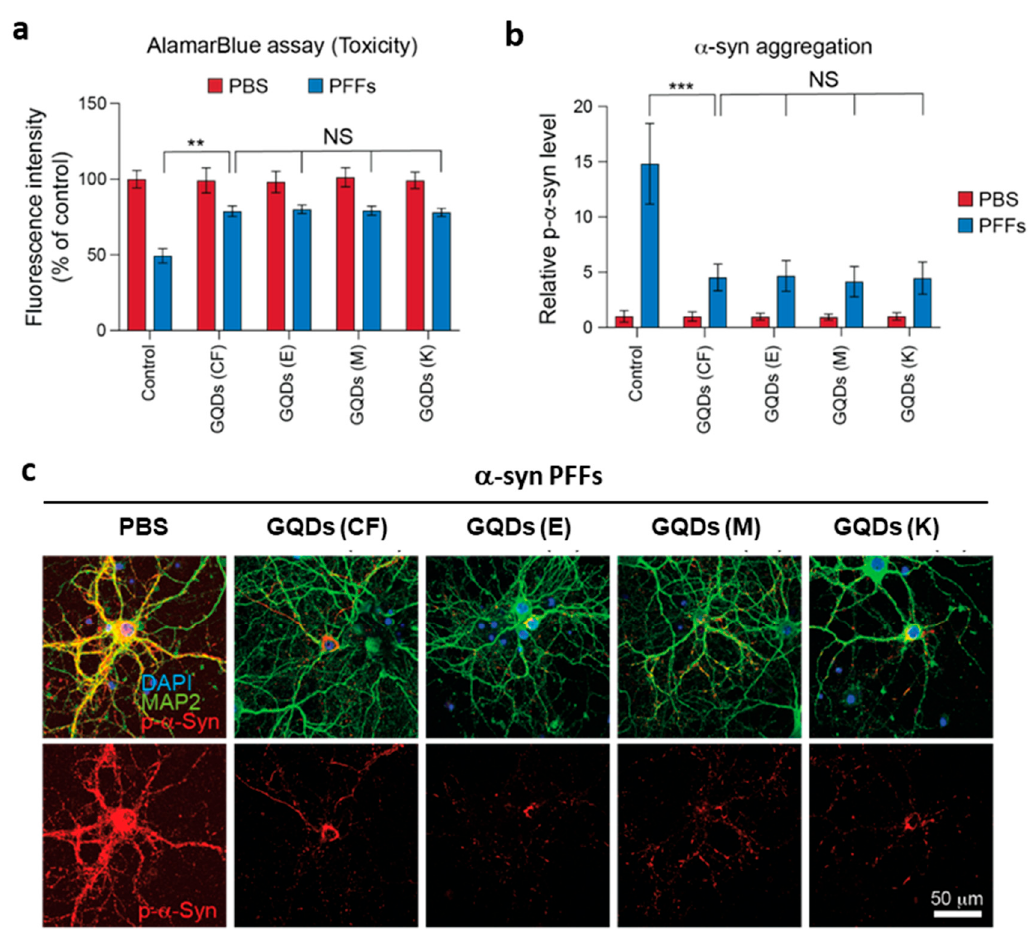
Figure 4. The effect of coffee bean-derived GQDs on α -syn PFFs-induced primary neuronal toxicity and α -syn pathology. ( a ) The mouse cortical neurons (10 DIV) were treated with 5 μ g/mL of α -syn PFFs with carbon fiber derived GQDs (CF, 5 μ g/mL, n = 6) or coffee bean-derived GQDs (E: Ethiopia, 5 μ g/mL, n = 6; M: Mandheling, 5 μ g/mL, n = 6; K: Kenya AA, 5 μ g/mL, n = 6). Neuronal toxicities were measured by alamarBlue assay at 7 days after treatment. ( b - c ) Representative p- α -syn immunostained neurons at 7 days after treatment with p- α -syn antibody. The p- α -syn immunofluorescence intensities were assessed and normalized to the PBS control ( n = 6, each group). Significant levels are denoted as asterisks: * p < 0.05, ** p < 0.01, and *** p < 0.001 via one-way ANOVA with Tukey’s multiple comparisons test.